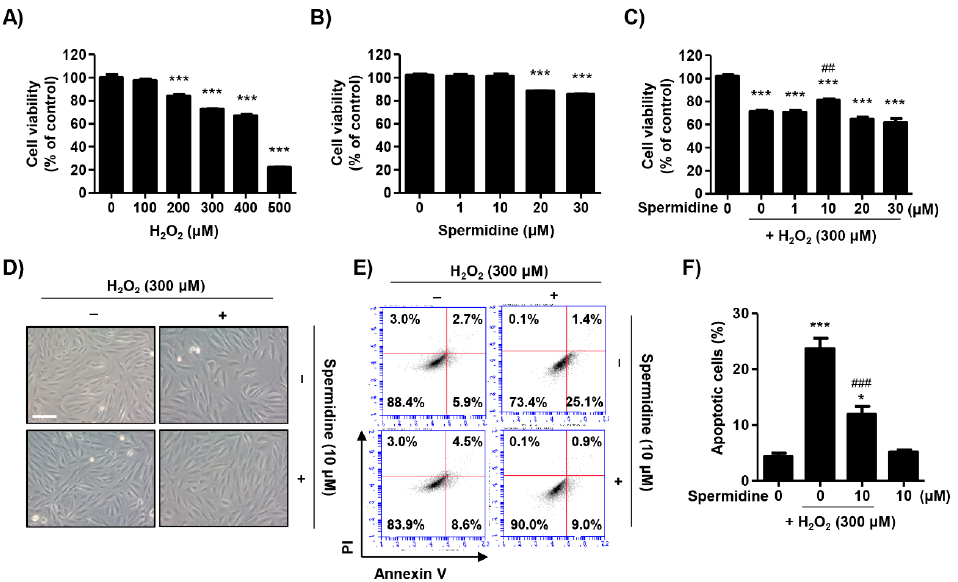
Figure 1. Effect of spermidine on apoptotic cell death in H 2 O 2 -stimulated ARPE-19 cells. ( A , B ) ARPE-19 cells were treated with various concentrations of H 2 O 2 ( A ) or spermidine ( B ) for 24 h. ( C – F ) Cells were pre-treated with the indicated concentrations of spermidine for 1 h and then additionally incubated with 300 μ M H 2 O 2 for 24 h. ( A – C ) Cell viability was measured via 3-(4,5-dimethylthiazol-2-yl)-2,5-diphenyltetrazolium bromide (MTT) assay. Data are expressed as the mean ± SD ( n = 5). *** p < 0.001 when compared to control. ## p < 0.01 when compared to H 2 O 2 -treated cells. ( D ) Morphological changes observed under an inverted microscope (scale bar; 75 μ m). ( E ) Flow cytometry: annexin V and propidium iodine (PI). ( F ) The percentages of apoptotic cells were determined by counting the percentage of annexin V-positive cells. Data are expressed as the mean ± SD ( n = 4). * p < 0.05 and *** p < 0.001 when compared to control. ### p < 0.001 when compared to H 2 O 2 -treated cells.